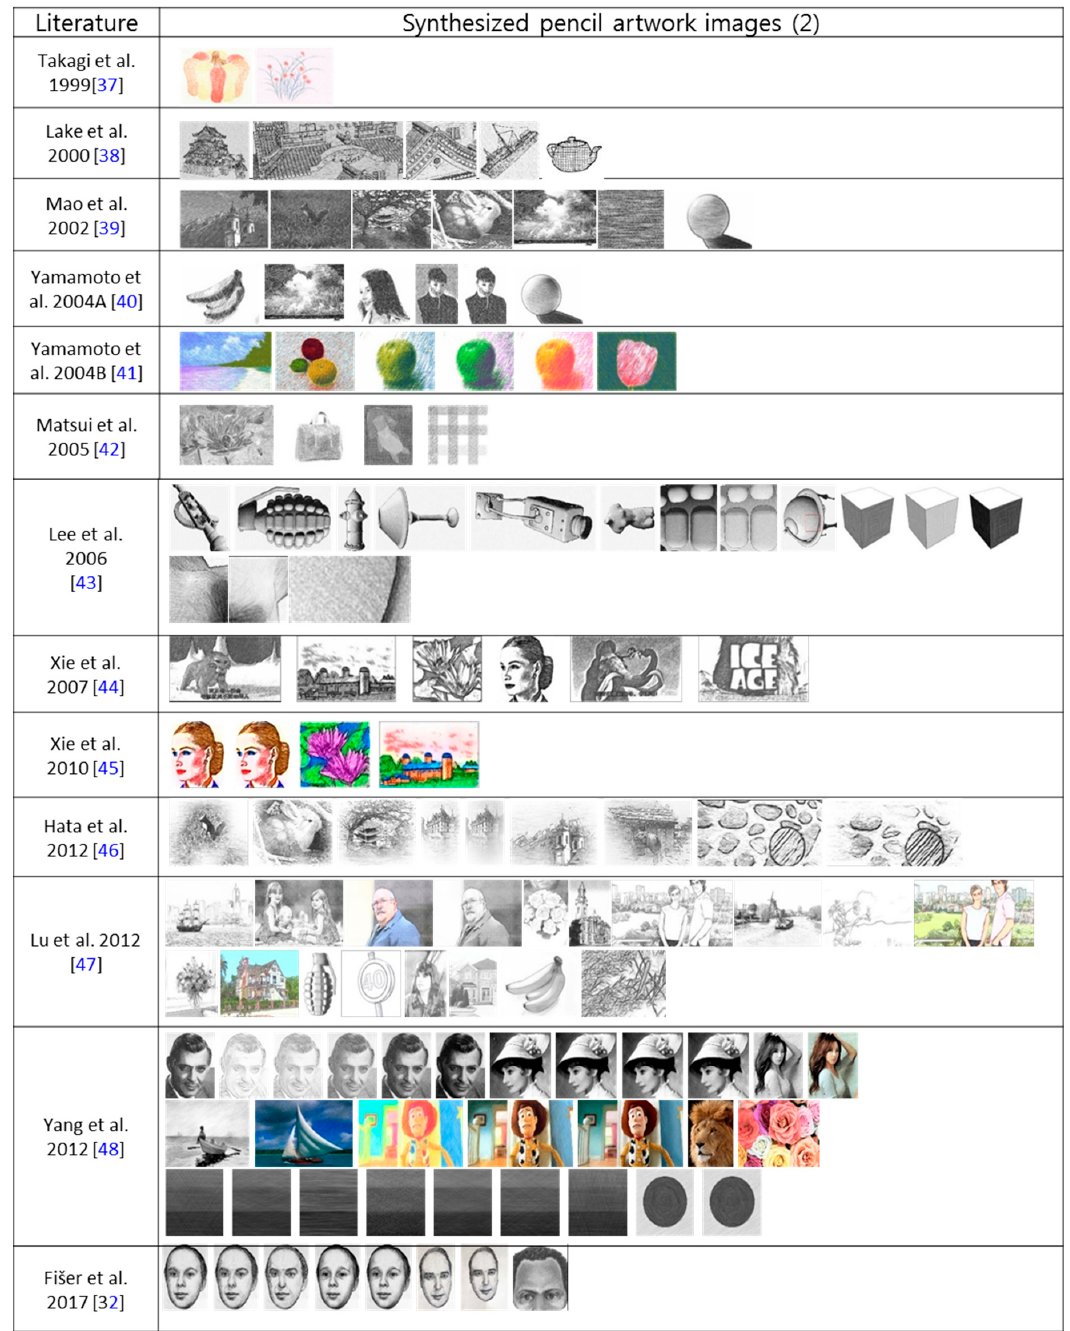
Figure 16. Pencil images in SynthSet . Figure A3. Pencil images in SynthSet